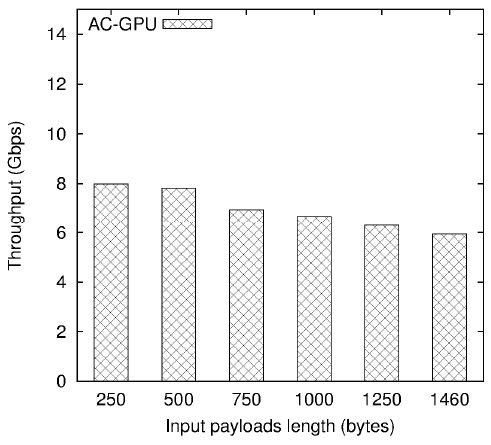
Figure 5. The GPUs with different full matching buffer sizes.